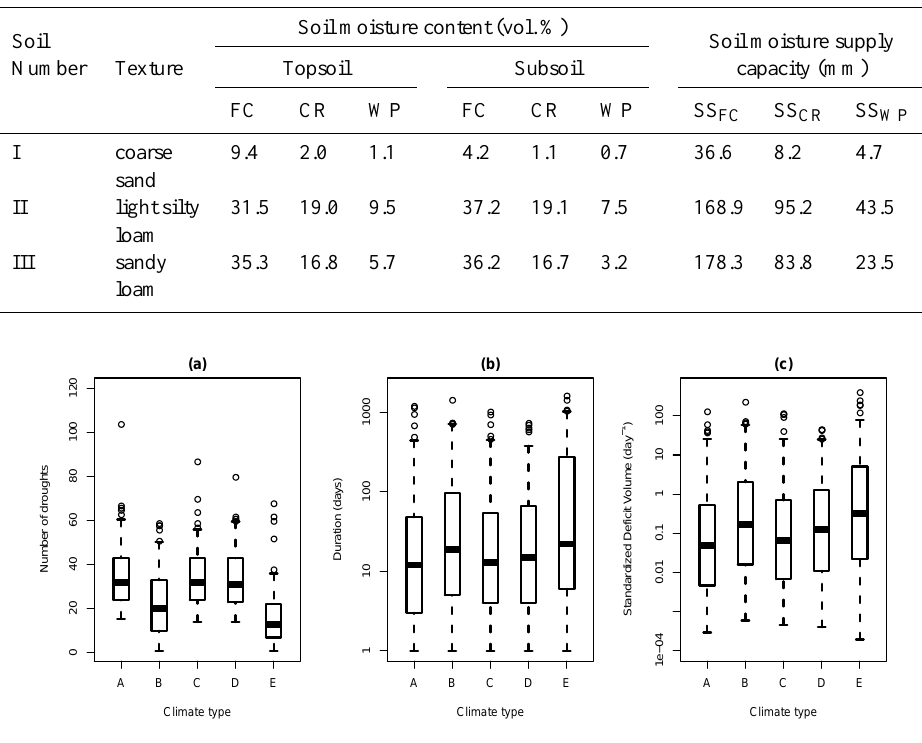
Fig. 3. Summary statistics (box: 25, 50 and 75 deciles, whiskers: 5 and 95 deciles) of hydrological drought characteristics of all drought events for each of the major climate types (A–E); Soil II and groundwater system j = 250 day, period 1958–2001. (a) number of droughts, (b) drought duration, and (c) standardized deficit volume. The circles represent extreme events beyond D95 for the 96, 97, 98, 99 and 100 deciles. Please note that y-axis of (a) is on linear scale, and (b) and (c) are on log scale.